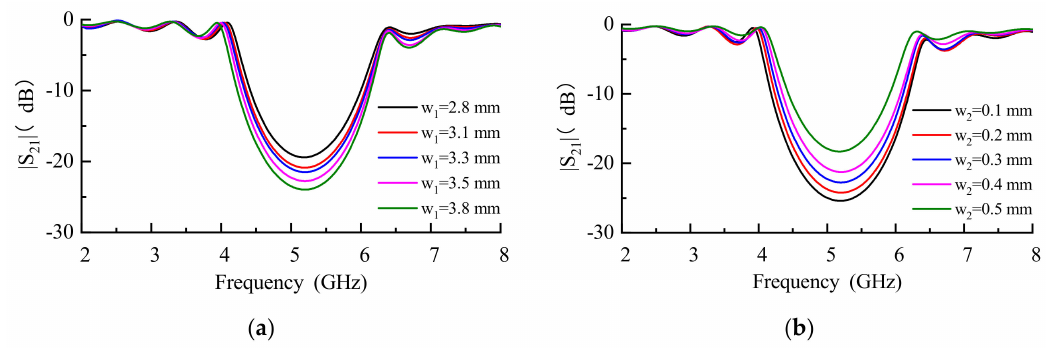
Figure 2. ( a ) S 21 with di ff erent w 1 by high frequency structure simulator (HFSS); ( b ) S 21 with di ff erent w 2 by using HFSS.